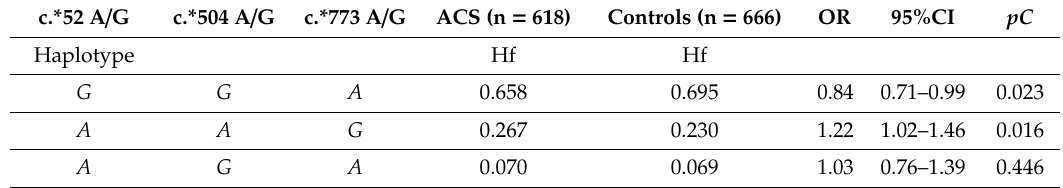
Table 3. Frequencies of LDLR haplotypes in patients with ACS and healthy